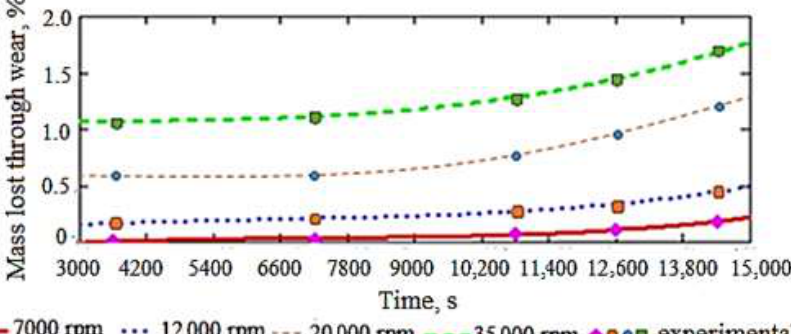
Figure 4. Variation over time of the material mass lost by the active side of a dental milling cutter through wear, described by the interpolation polynomial of third degree at four values of the rotational velocity.